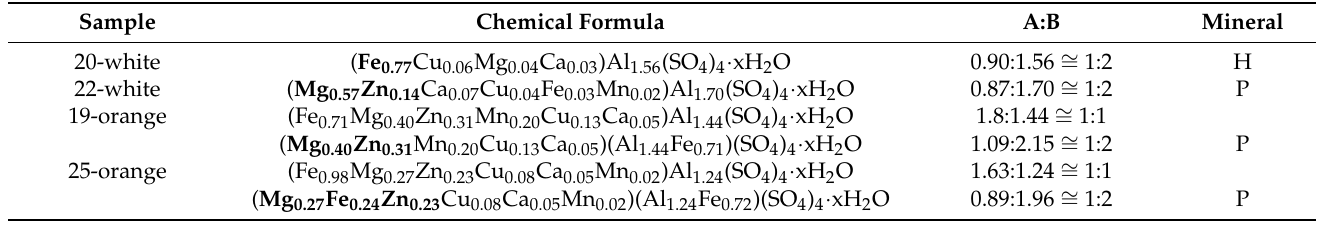
Table 3. Calculated chemical formula (based on XRF data) for the Algares samples from the halotrichite group, AB 2 (SO 4 ) 4 · 22H 2 O; x—number of water molecules, not calculated, as loss on ignition was not obtained; principal cations on A site are assigned in bold. H—halotrichite; P—pickeringite.